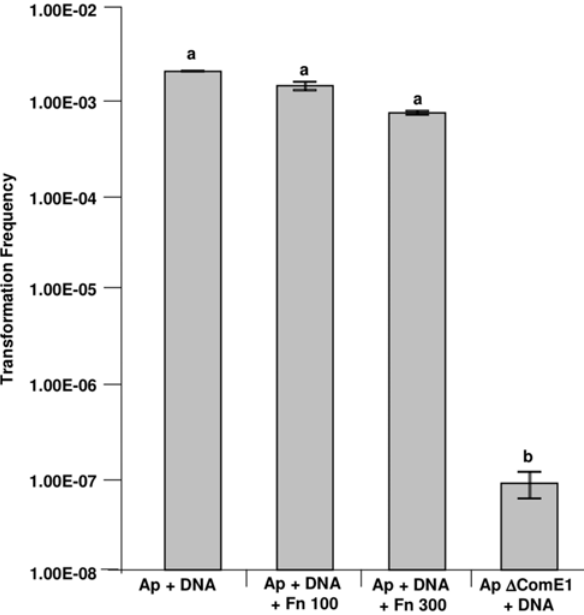
Figure 9. Comparison of the transformation frequency of wild- type A.pleuropneumoniae and ApcomE1 . The effect of the presence of Fn on the transformation frequency of wild-type A. pleuropneumo- niae was also tested. Bars with different letters are significantly different from each other (one-way ANOVA, P , 0.001).